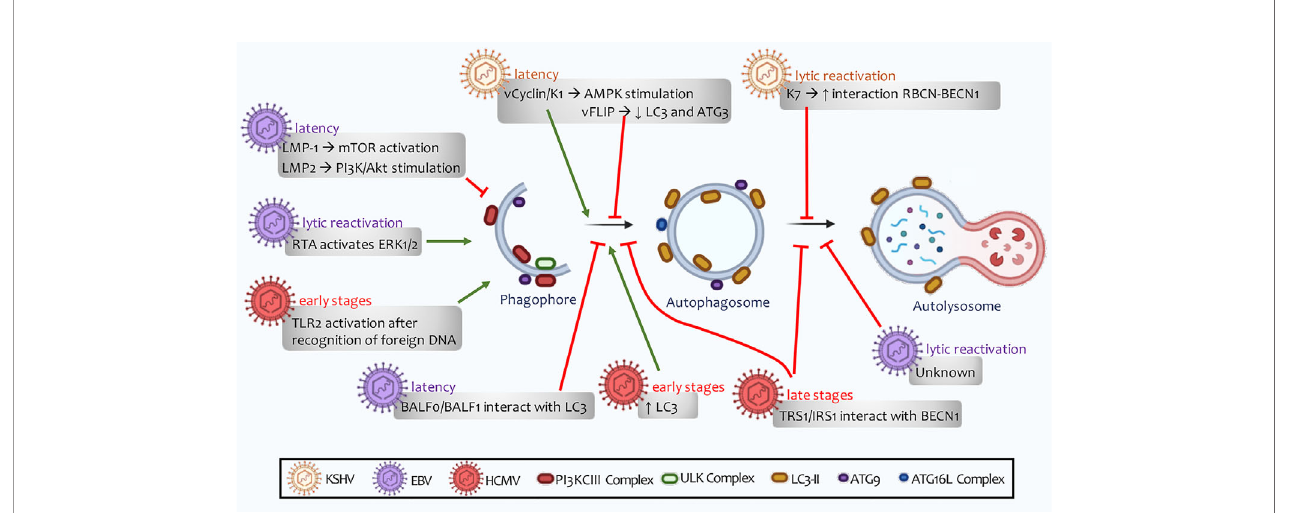
FIGURE 6 | Human Herpesvirus regulation of autophagy. The viral ability to regulate autophagy depends on stage of infection. This regulation can alternate between latent, de novo , or lytic reactivation infections. A distinguishing feature of these lymphotropic viruses is their ability to promote autophagy induction, a process followed by inhibition of autophagosome maturation. This defective autophagy does not allow autolysosomes to form, and therefore to perform successful